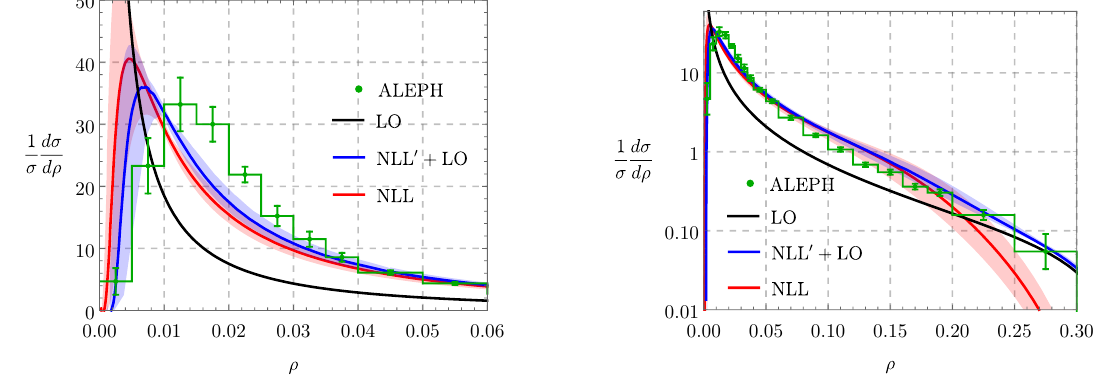
Figure 10 . Jet-mass distribution and comparison to ALEPH data [36] (green dots with error bars). The black curve represents the LO prediction for jet mass, where its analytical expression is given in (E.3). The red curve is the NLL resummation result and the band is from scale variation. The blue curve corresponds to NLL 0 + LO results, in which we switched o(cid:11) resummation e(cid:11)ects at large (cid:26) using